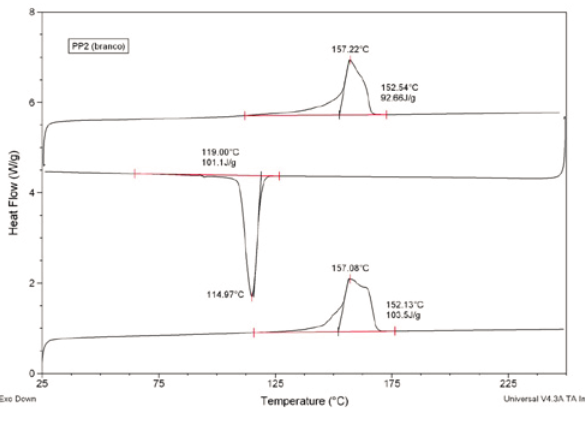
FIGURE 10- Differential Scanning Calorimetry of Group 3 (Nonwoven prosthesis). The bottom curve represents the first heating curve. In the middle the crystallization point and peak. At the top of the graph is the second heating. It was observed no significant differences to Group